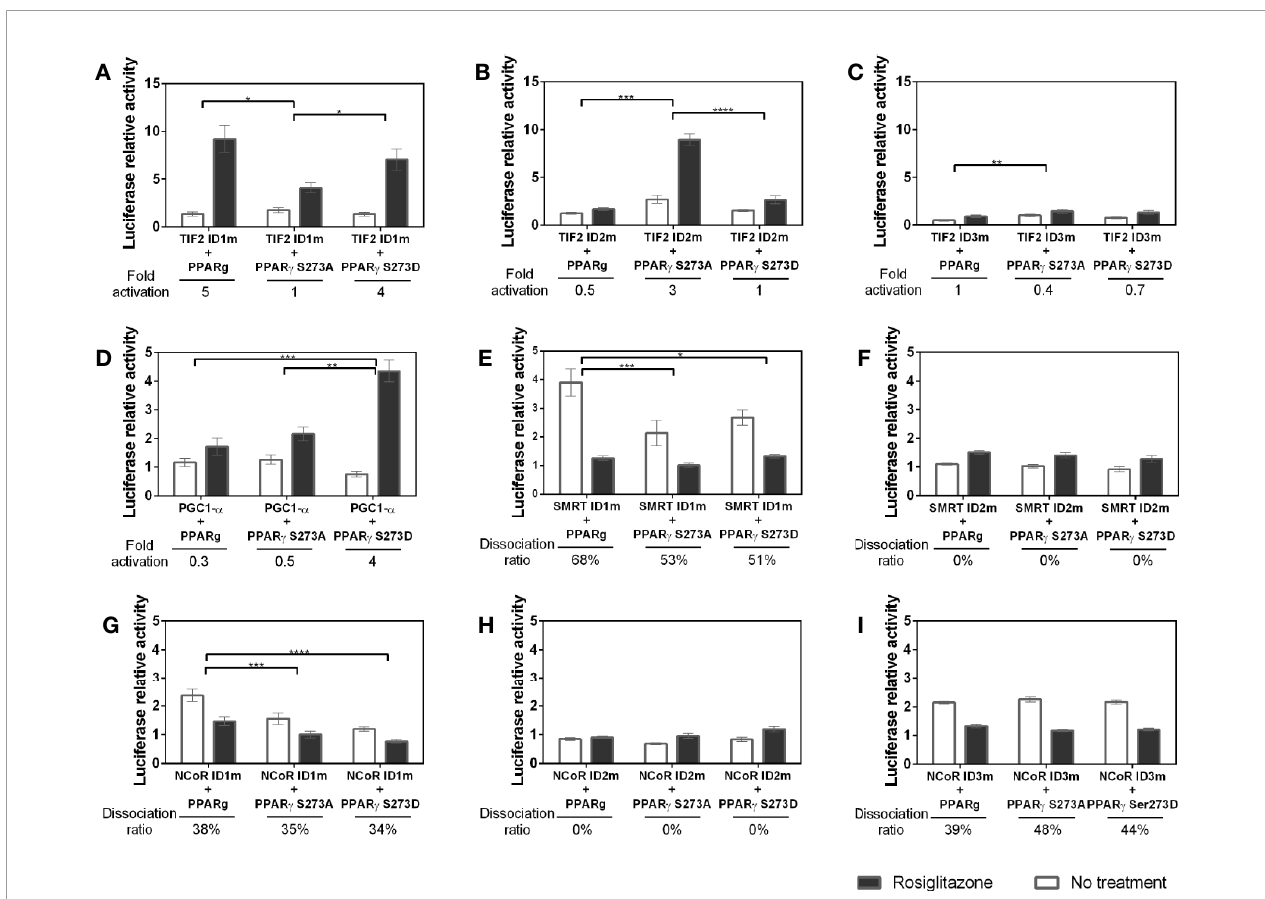
FIGURE 7 | Interaction between coregulators and PPAR g in different phosphorylation states. Mammalian two hybrid assays were performed to evaluate whether the S273 mutation in the receptor interferes with its interaction with the coregulators. The PPAR g S273A mutant prevents the occurrence of phosphorylation and the PPAR g S273D mutant is a phosphomimic. (A – C) Interaction between TIF2 mutants and PPAR g in different phosphorylation states. (D) Interaction between PGC1- a mutant and PPAR g in different phosphorylation states. (E, F) Interaction between SMRT mutants and PPAR g in different phosphorylation states. (G – I) Interacton between NCoR mutants and PPAR g in different phosphorylation states. Error bars, SEM. (n = 15) Statistical analysis: two-way ANOVA. P values: p ≤ 0.05*; p ≤ 0.01**; p ≤ 0.001***; p ≤